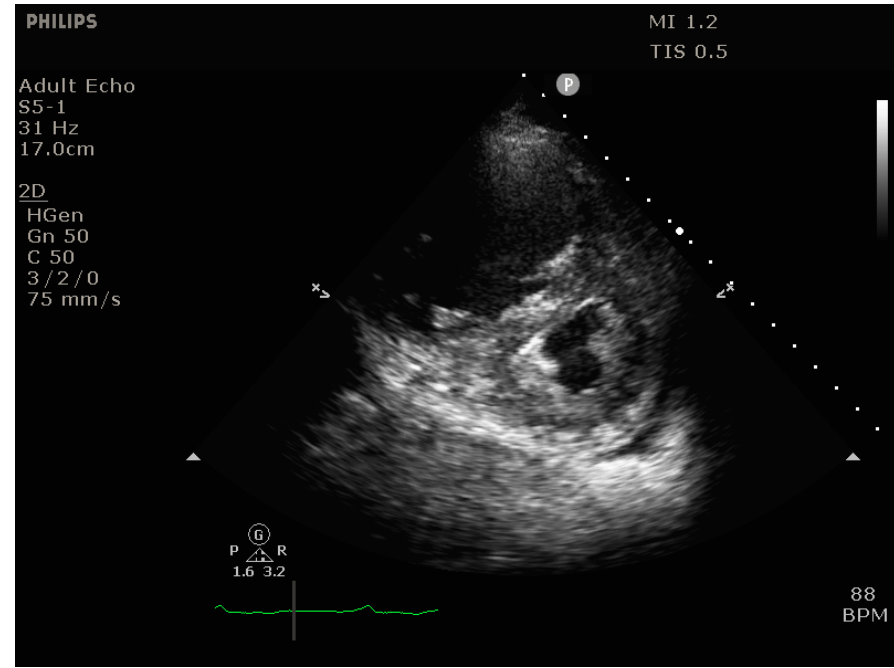
Figure 3. Transthoracic echocardiogram (parasternal short axis view) showing massive D ‐ shaping of the interventricular septum.